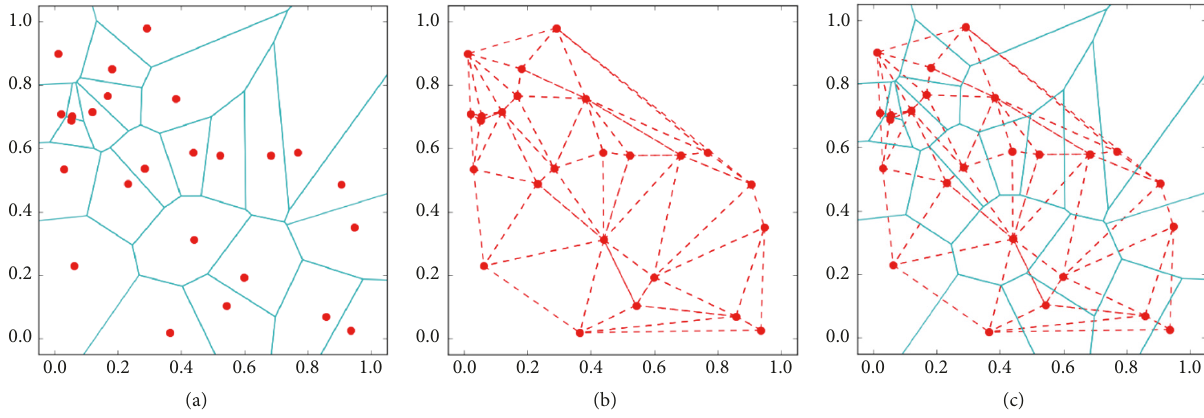
Figure 4: An example of the Voronoi tessellation (cyan solid lines, (a)), and its dual graph, the Delaunay triangulation (red dashed lines, (b)) for the same set of seed points (red solid dots). The overlap of both aforementioned graphs to illustrate the duality (c).